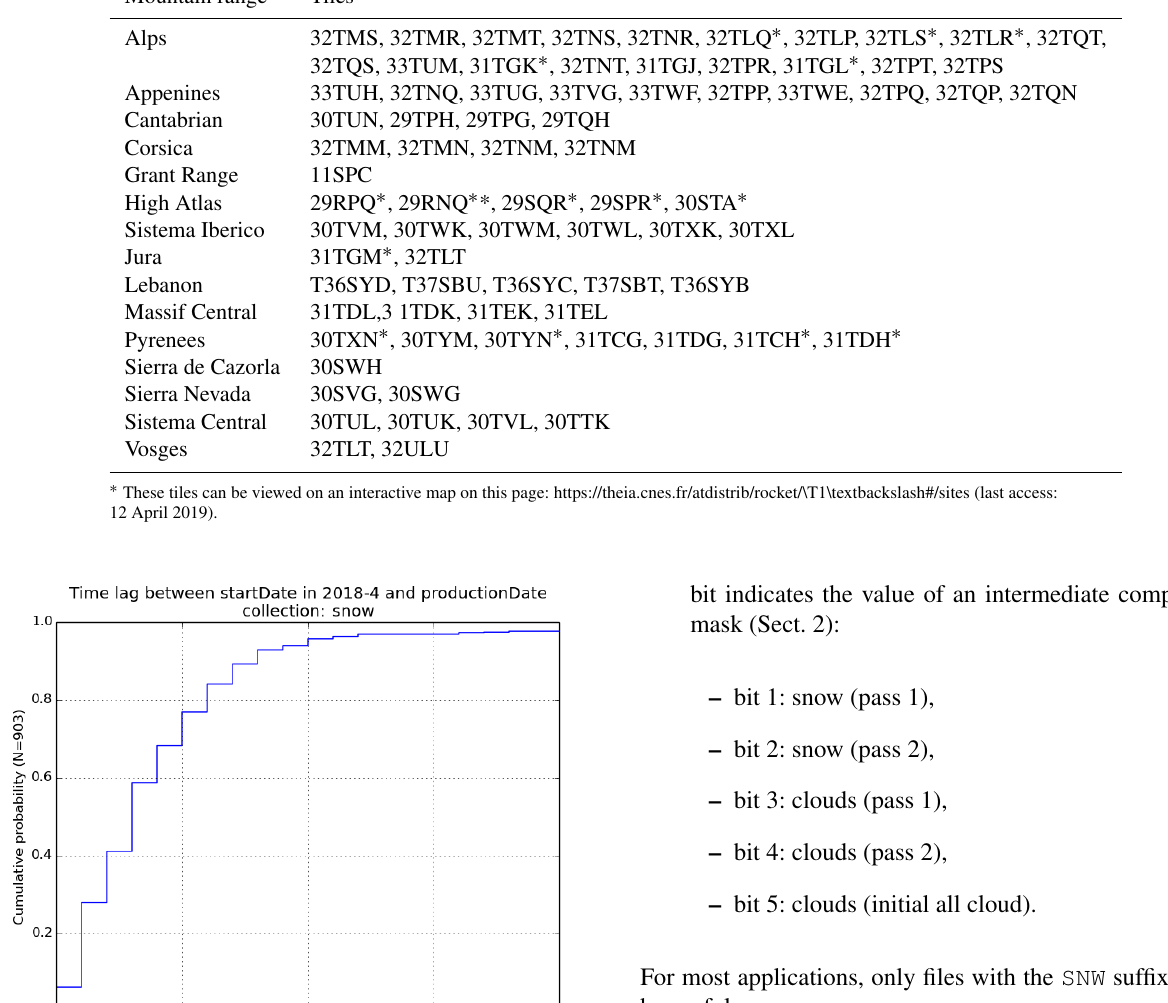
snow in grey (119,119,119) and no data in black (0,0,0) (see an example in Fig.